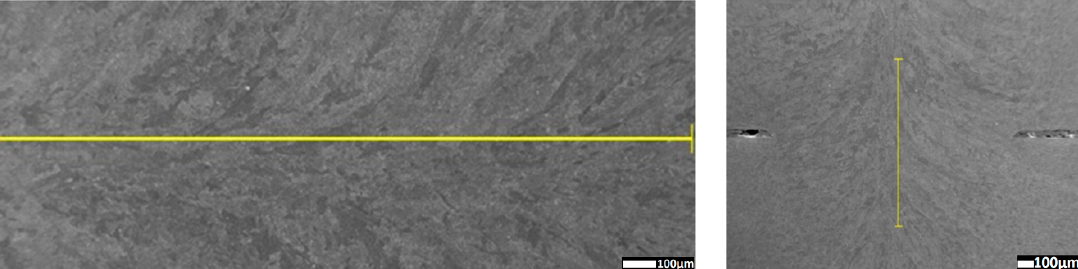
Figure 18. Measure line of fusion zone in overlap transition.